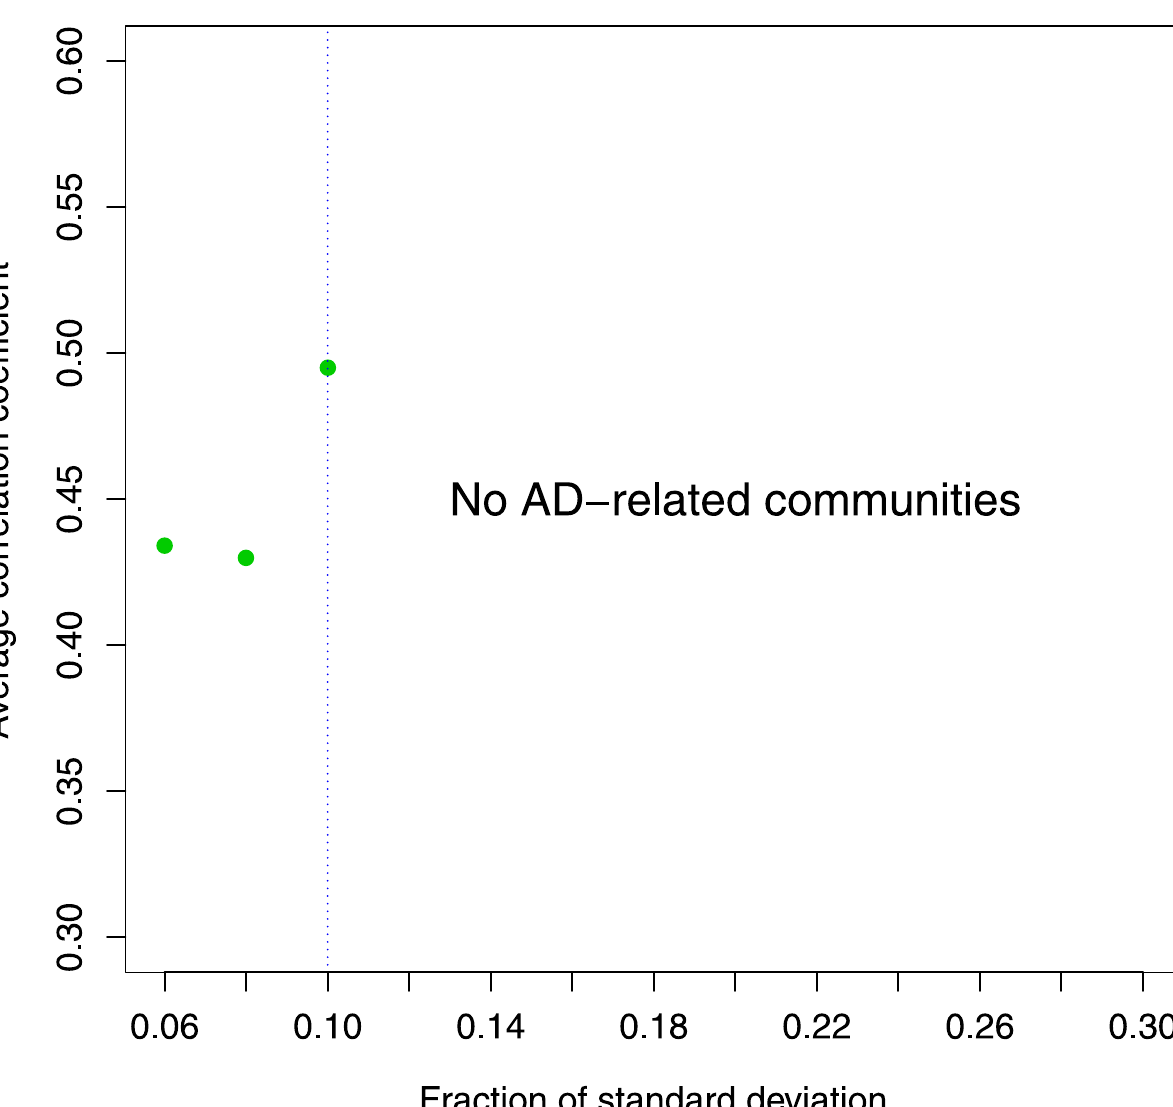
is the optimal cut that maximizes the average correlation between the communities max we did not find AD-related communities. max